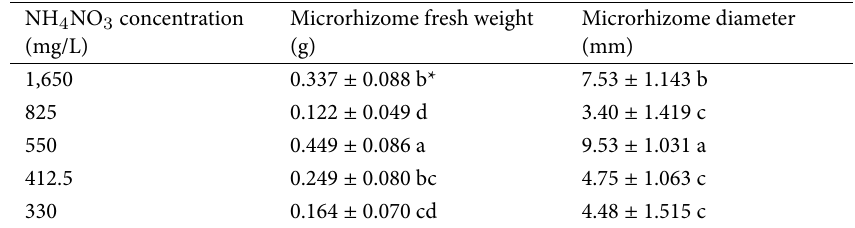
Table 7 Effect of ammonium nitrate (NH 4 NO 3 ) concentration on ginger microrhizome growth.